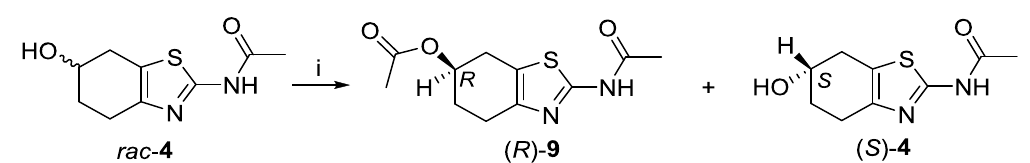
Table 2. Enzyme-catalyzed irreversible transesterification of alcohol rac - 4 in